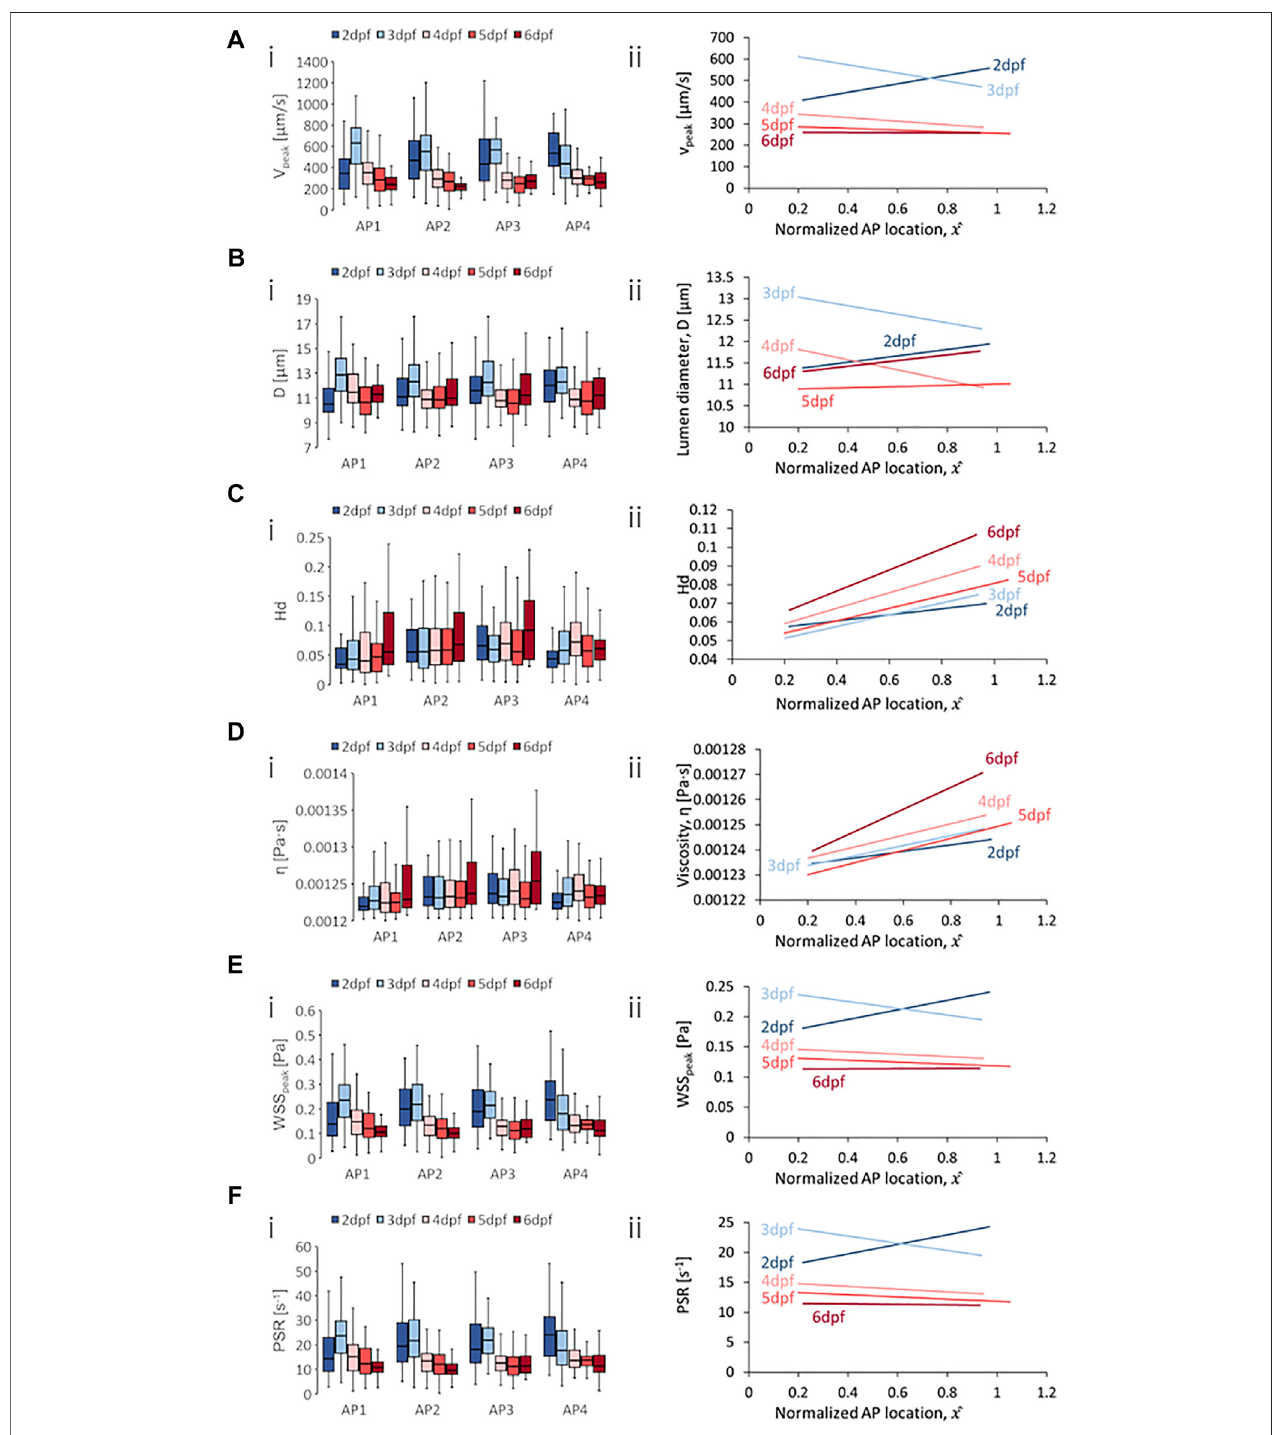
FIGURE 8 | Developmental trends of morphological and hemodynamic quantities in the dorsal longitudinal anastomotic vessel (DLAV). (A) The changes in V peak at four regions along the anterior-to-posterior (AP) axis (i) and the AP trend for V peak (ii) . (B) The changes in D at four AP regions (i) and the AP trend for D (ii) . (C) The changes in H d at four AP regions (i) and the AP trend for H d (ii) . (D) The changes in η at four AP regions (i) and the AP trend for η (ii) . (E) The changes in WSS peak at four APregions (i) andtheAPtrendfor WSS peak (ii) . (F) Thechangesin PSR atfourAPregions (i) andtheAPtrendfor PSR (ii) .Boxplotsin (i) ofPanels (A – D) showthe medianandthe fi rst(Q1)andthird(Q3)quartilelevelsofthehemodynamicquantityforthepooledzebra fi shdata.Thewhiskerbarsrepresentthemaximumandminimum ranges of the data that lie within 1.5 times of the interquartile range (IQR = Q3 − Q1) beyond Q1 and Q3.